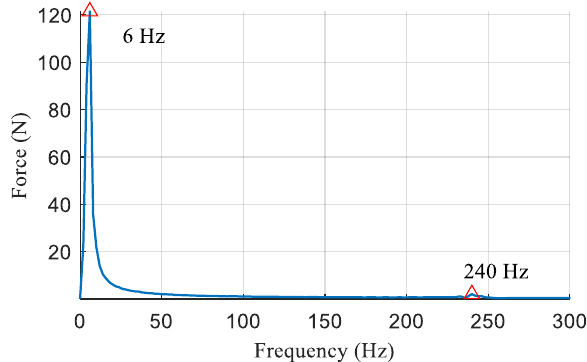
Figure 10. Single-sided amplitude spectrum of contact force.